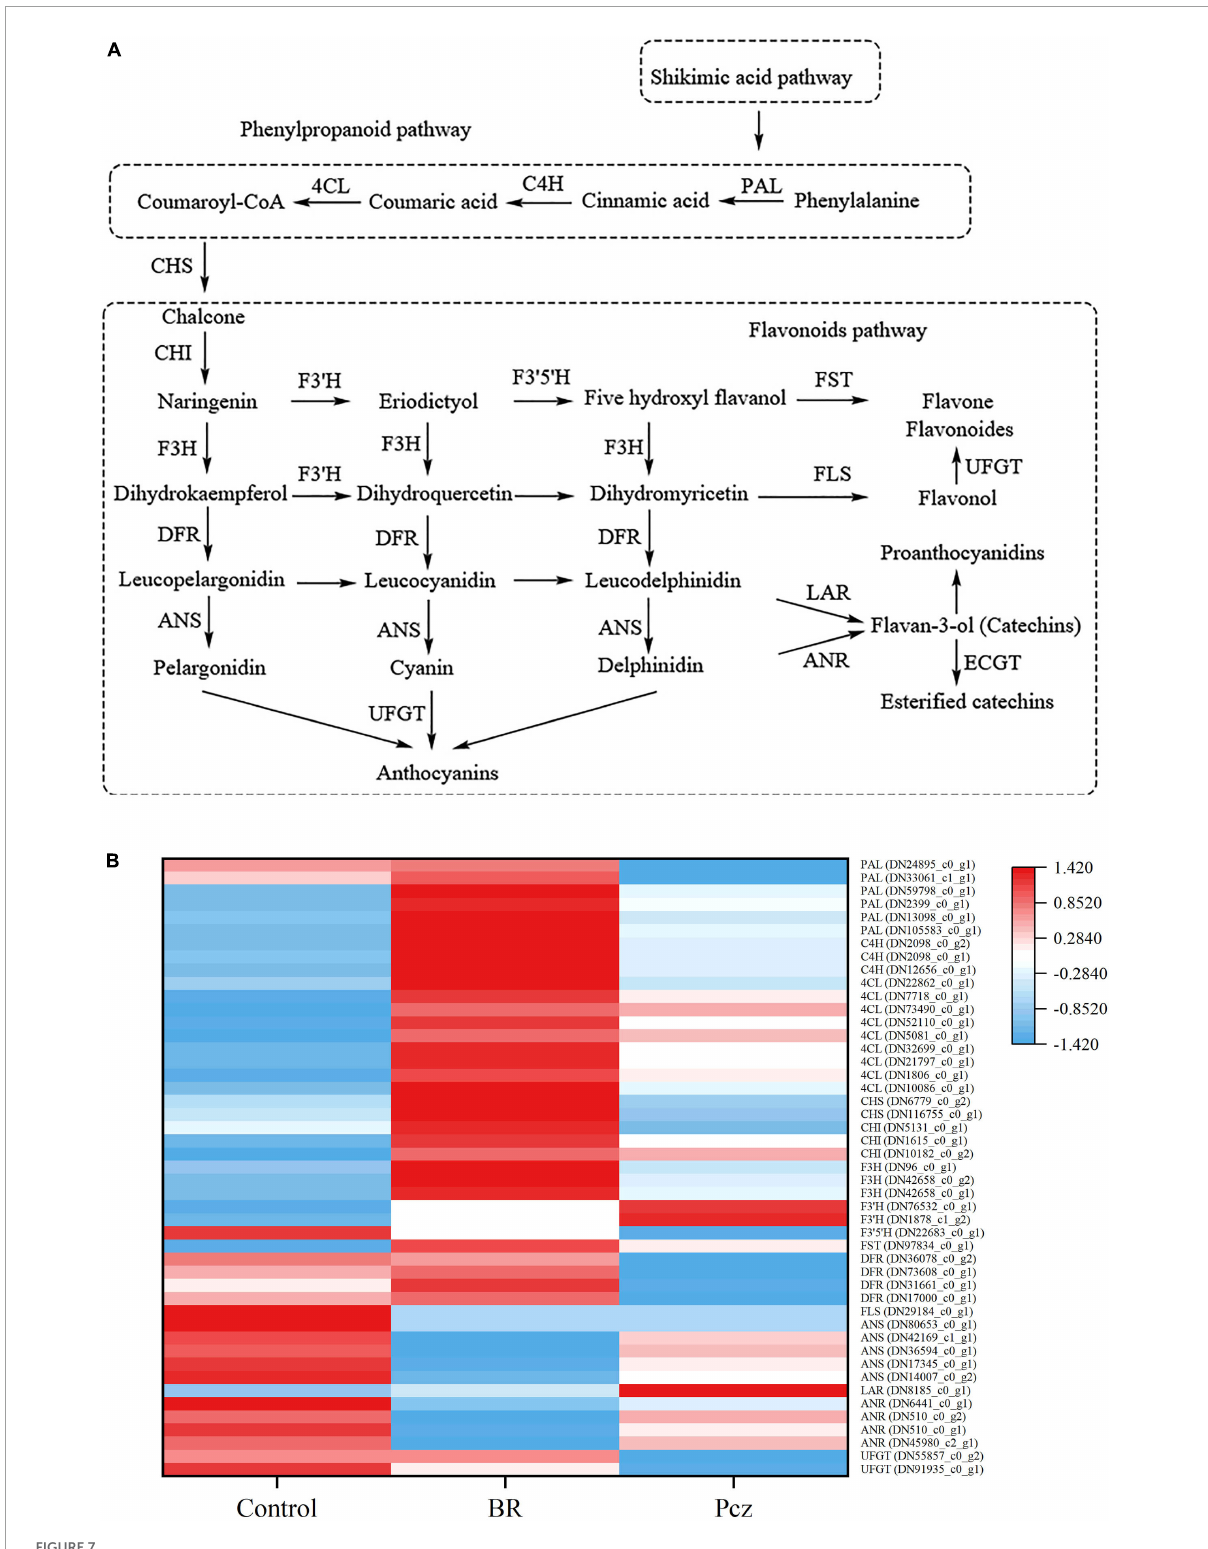
FIGURE7 Analysis of differentially expressed levels related to flavonoid biosynthesis pathway in bulbil of P. ternata under BR and Pcz treatments. (A) , the flavonoid biosynthetic pathway. (B) , the expression levels related to the flavonoid biosynthetic pathway. Blue indicates a lower expression level, whereas red indicates a higher expression level. All the data showed the average mean of three biological